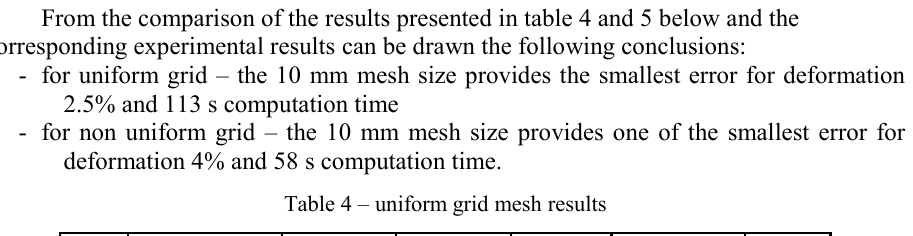
Fig.16 Mesh sizes - uniform grid Fig.17 Mesh sizes – non uniform